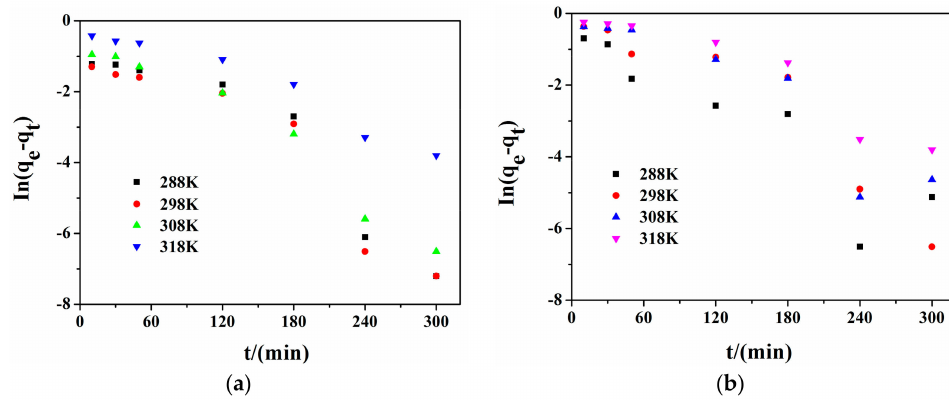
Figure 11. Effect of temperature on 1-naphthol adsorption on raw diatomite. ( a ) And calcined 450 ◦ C diatomite; ( b ) of pseudo-first order adsorption kinetics plots.